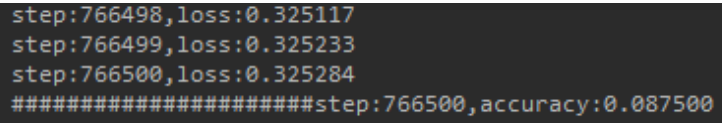
Figure 7. The training process with some captchas generated by the proposed